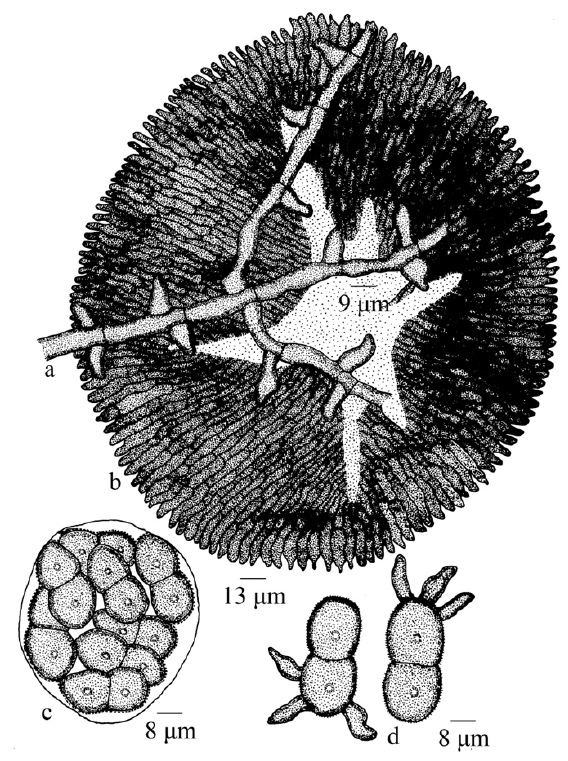
Figure 4. Asterina eleocarpigena sp. nov. a.Appressoriate mycelium, b. Thyriothecium, c. Ascus, d.